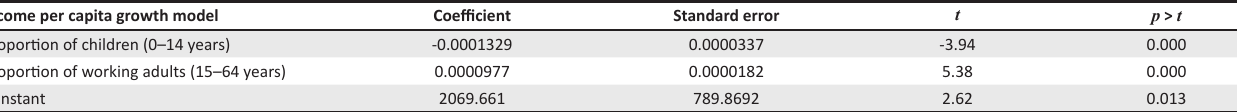
FIGURE 3: Statistical test of savings and population growth for the all Southern Africa Development Community countries. TABLE 3: Impact of age on income per capita. Income per capita growth model